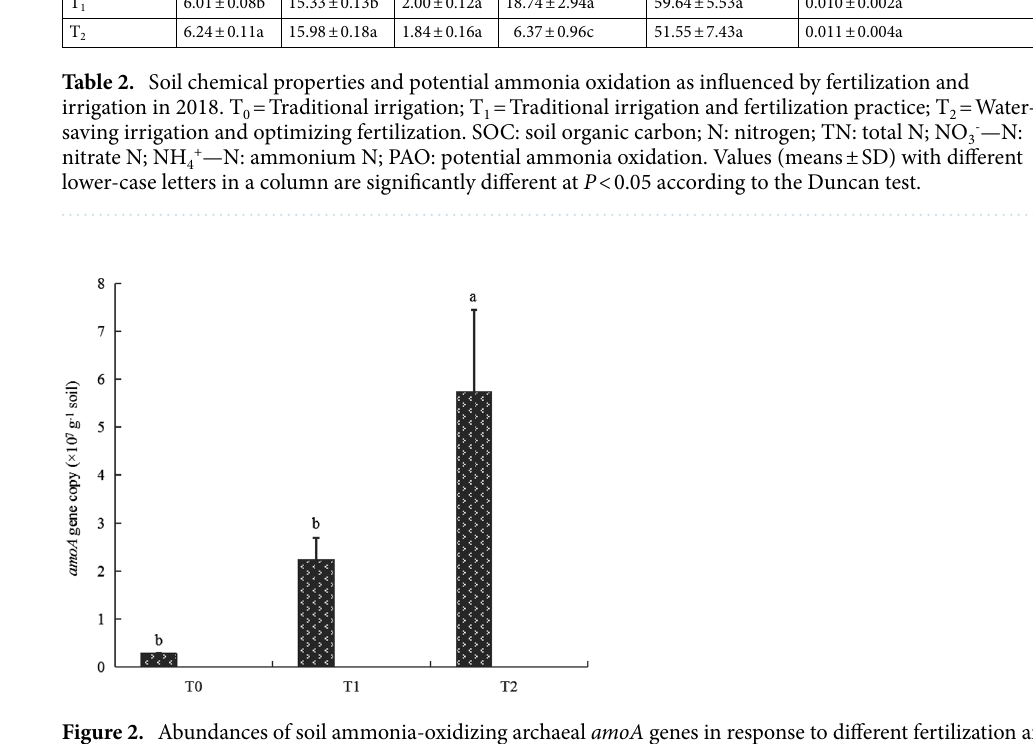
Figure 2. Abundances of soil ammonia-oxidizing archaeal amoA genes in response to different fertilization and irrigation. The different letters indicate significant differences (Duncan’s test, P < 0.05). Notes : T 0 = Traditional irrigation; T 1 = Traditional irrigation and fertilization practice; T 2 = Water-saving irrigation and optimizing fertilization.